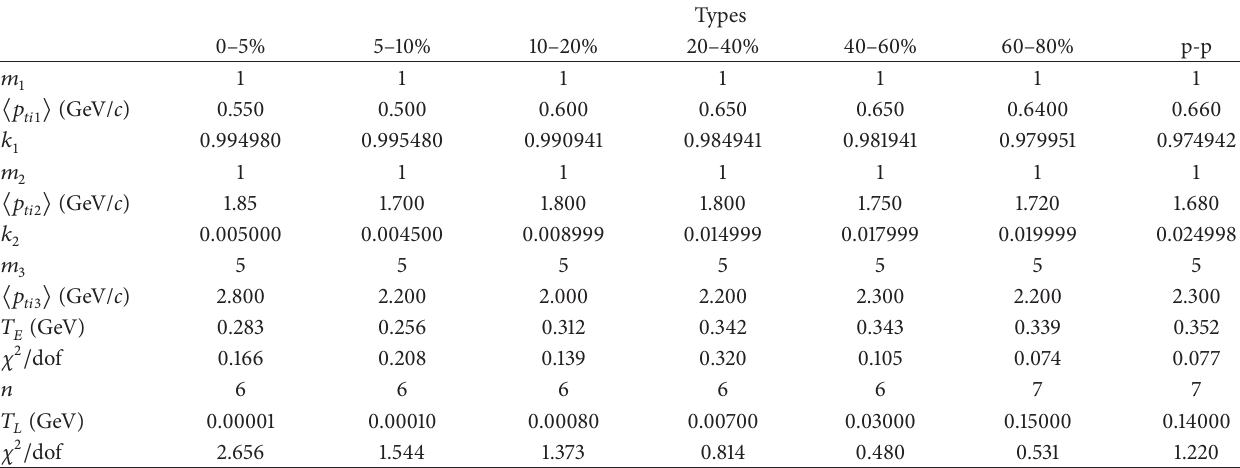
Table 6: Parameter values for the two kinds of curves in Figure 7(a). The values of 𝜒 2 / dof and extracted temperatures are given. The errors for 𝑚 1,2,3 and 𝑛 can be neglected, and the relative errors for other parameters are less than